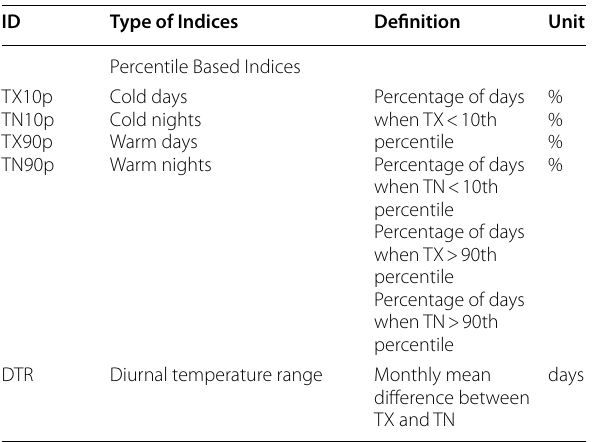
Table 1 Calculated temperature indices for the study areas by ETCCDI ID Type of Indices Definition Unit